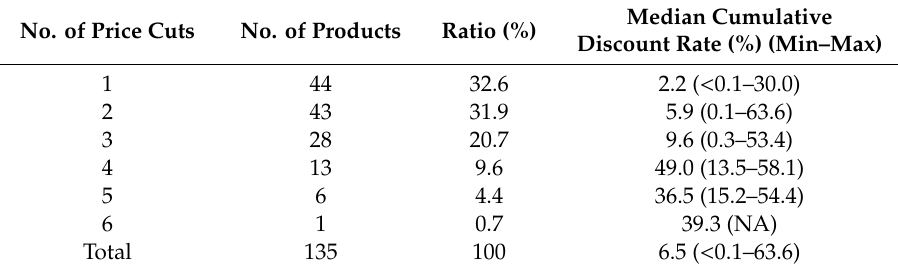
Table 3. Number of price cuts and median cumulative price cut rates of new